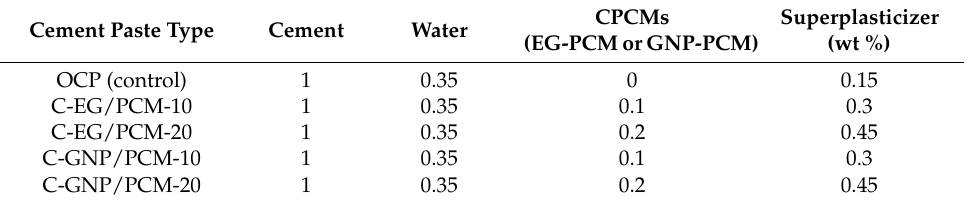
Table 2. Mix proportion (mass ratio) of composite phase change material (CPCM) in cement